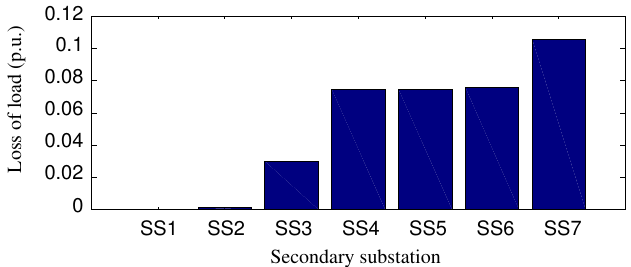
Figure 10. Average loss of load per substation in case